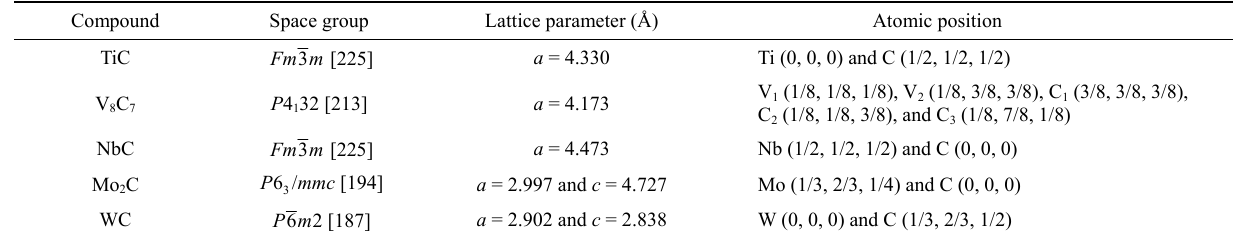
Table 1 Crystal structures and lattice parameters of binary carbides (TiC, V 8 C 7 , NbC, Mo 2 C, and WC) Compound Space group Lattice parameter